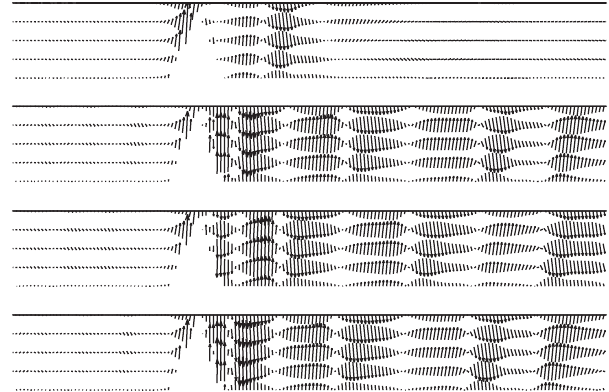
Figure 15: Velocity field on the 𝑈 , 𝑊 plane and half way through the 𝑦